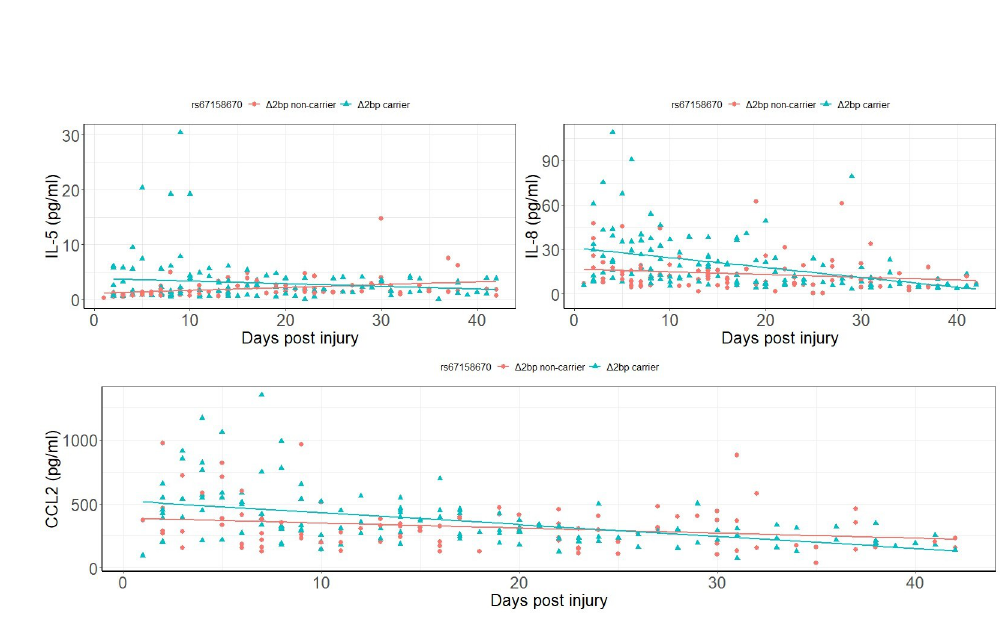
Fig 1. Temporal effect of inflammatory mediators in severe SCI is a function of